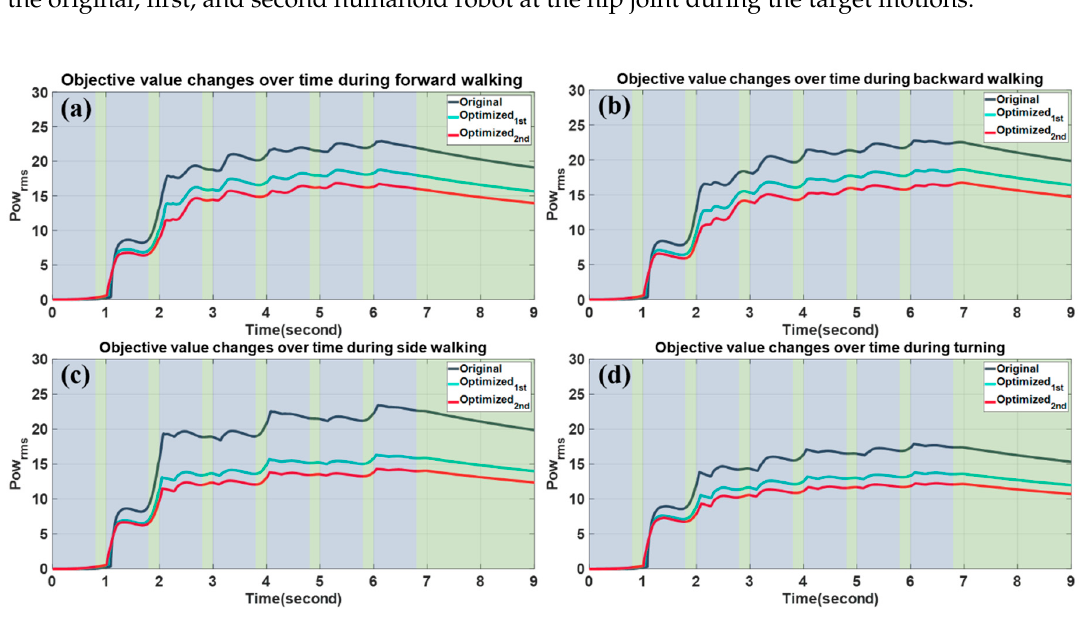
Figure A1. Objective value changes over time during ( a ) forward walking, ( b ) backward walking, ( c ) sideways walking, and ( d ) turning. Optimized 1st and 2nd indicate the models after the first and second optimization, respectively. Blue and green colored backgrounds indicate a single and double support phase during target motion,